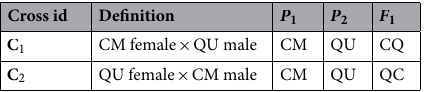
Table 1. Definitions of crosses as function of parents and F 1